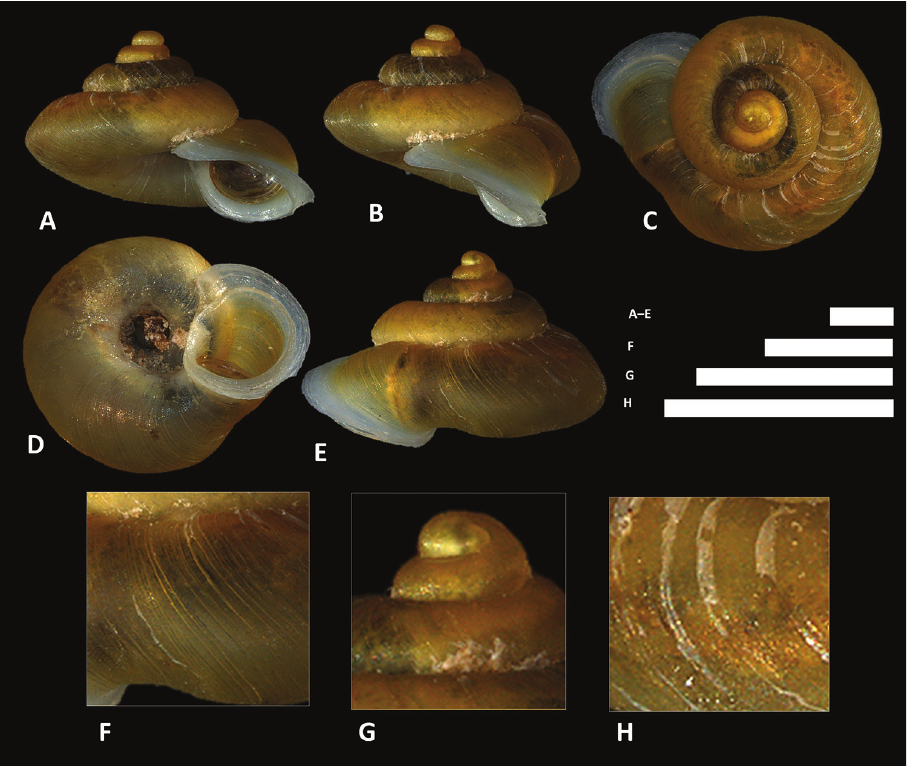
Figure 11. Alycaeus carinata Maassen, 2006 A–E Shell of paratype, RMNH 104427 F–H Close up of shell of paratype, RMNH 104427. Scale bars: A–G 1 mm; H 0.5 mm. All photographs by Thor Seng